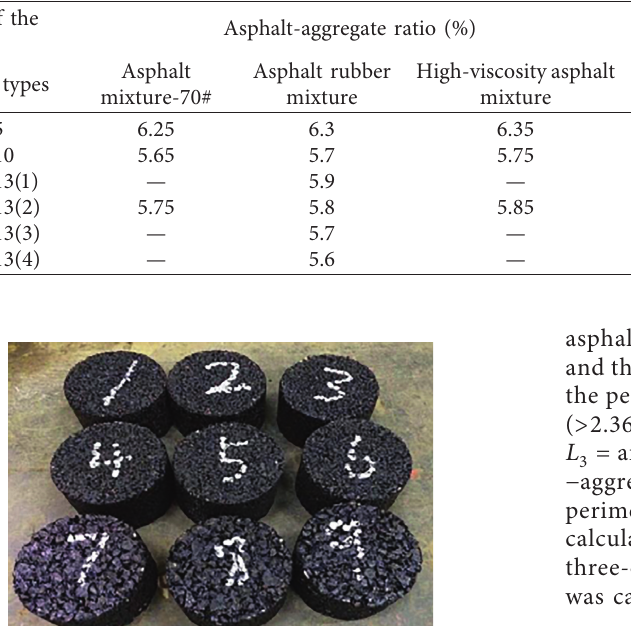
Table 5: Asphalt-aggregate ratio and the voids ratio of different mixture.